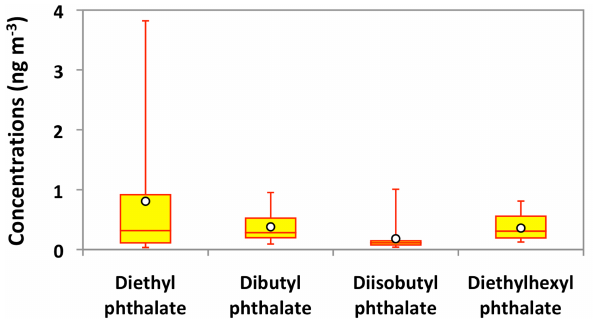
Figure 10. Molecular distributions of phthalate esters in PM 2 . 5 aerosols collected in central Alaska. See Fig. 5 for the description of the box-and-whisker diagram.